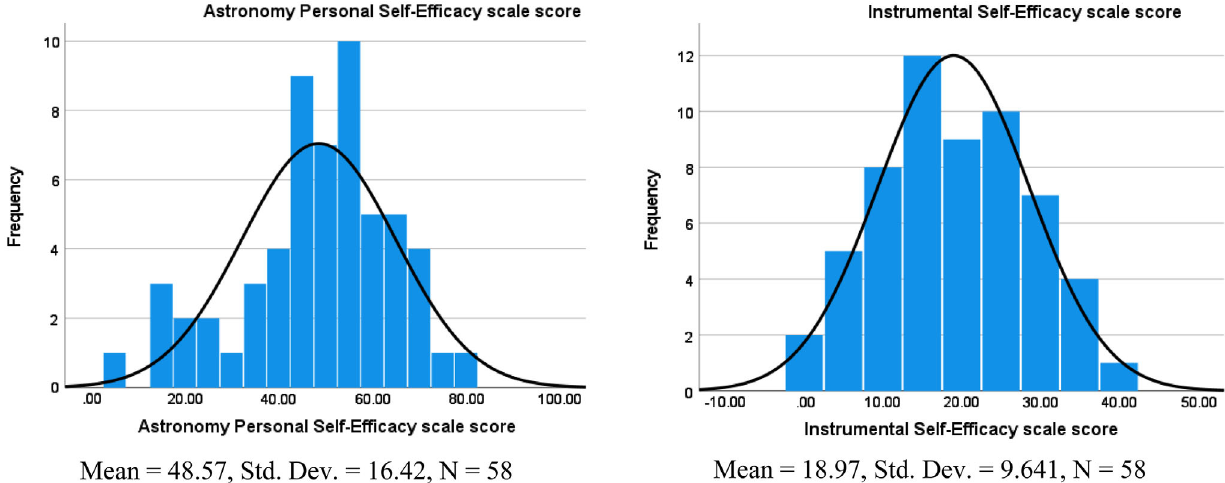
FIG. 4. Nonlab group frequency distribution of the APSE (left) and ISE (right) for cohort